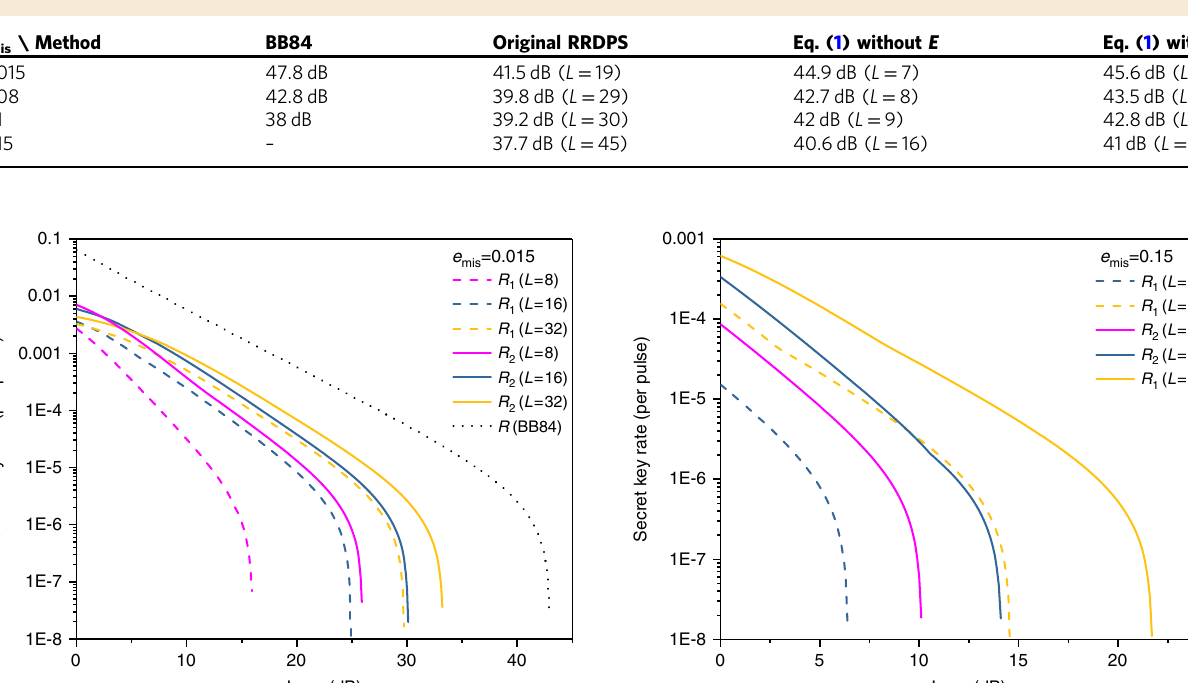
Table 2 loss max (dB) of BB84 and RRDPS with different methods